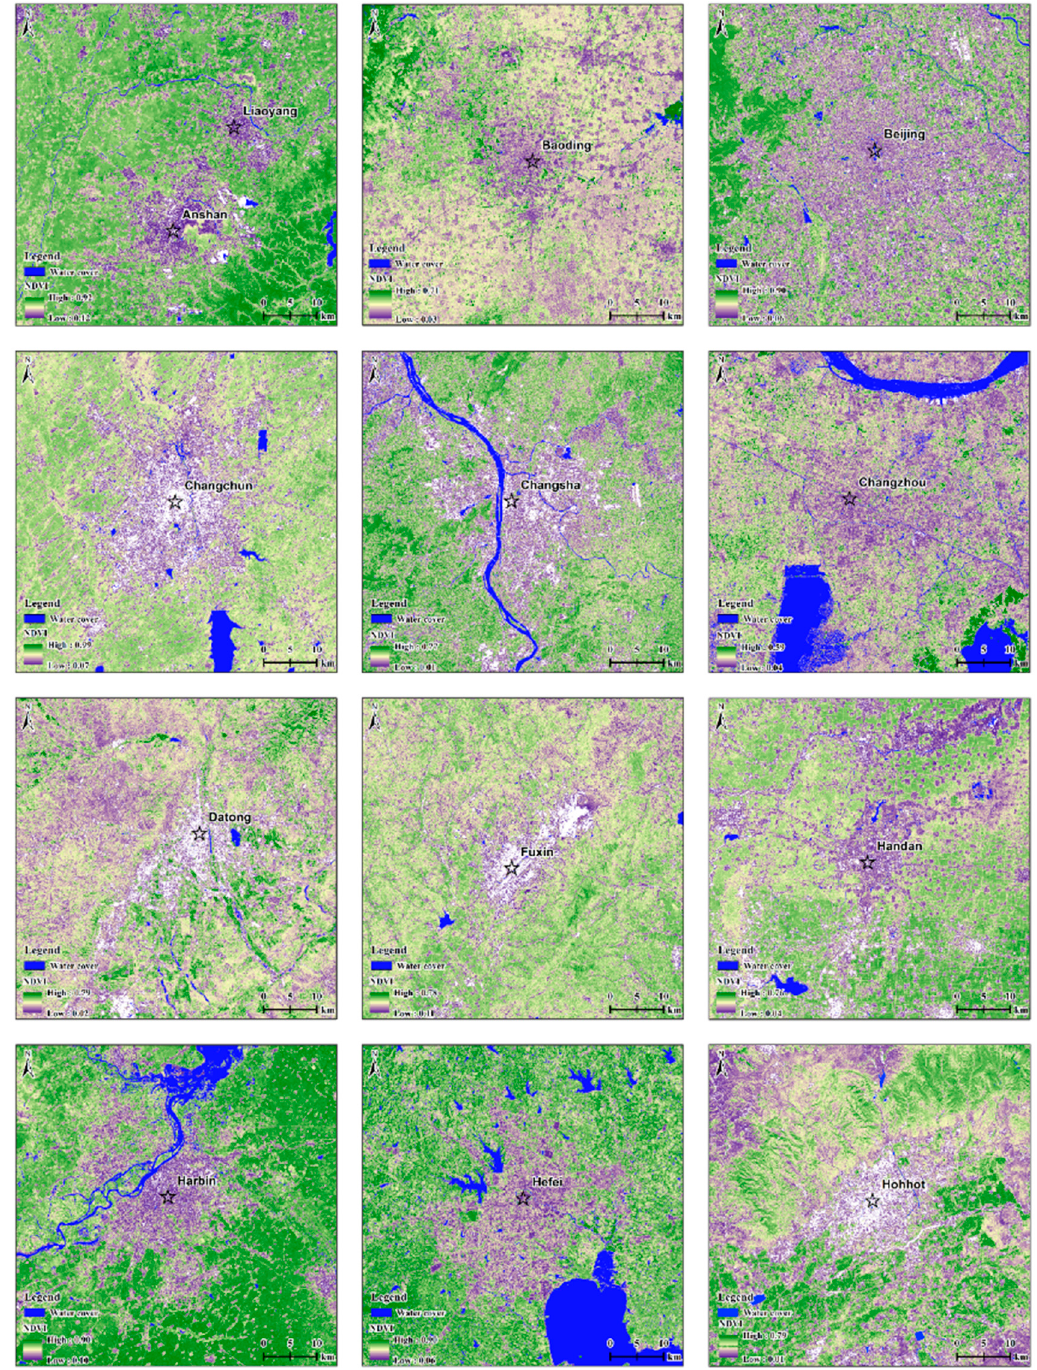
Figure A3. Map of the normalized difference vegetation index (NDVI) data and water cover (WC) Figure A3. data for the 32 Chinese cities.